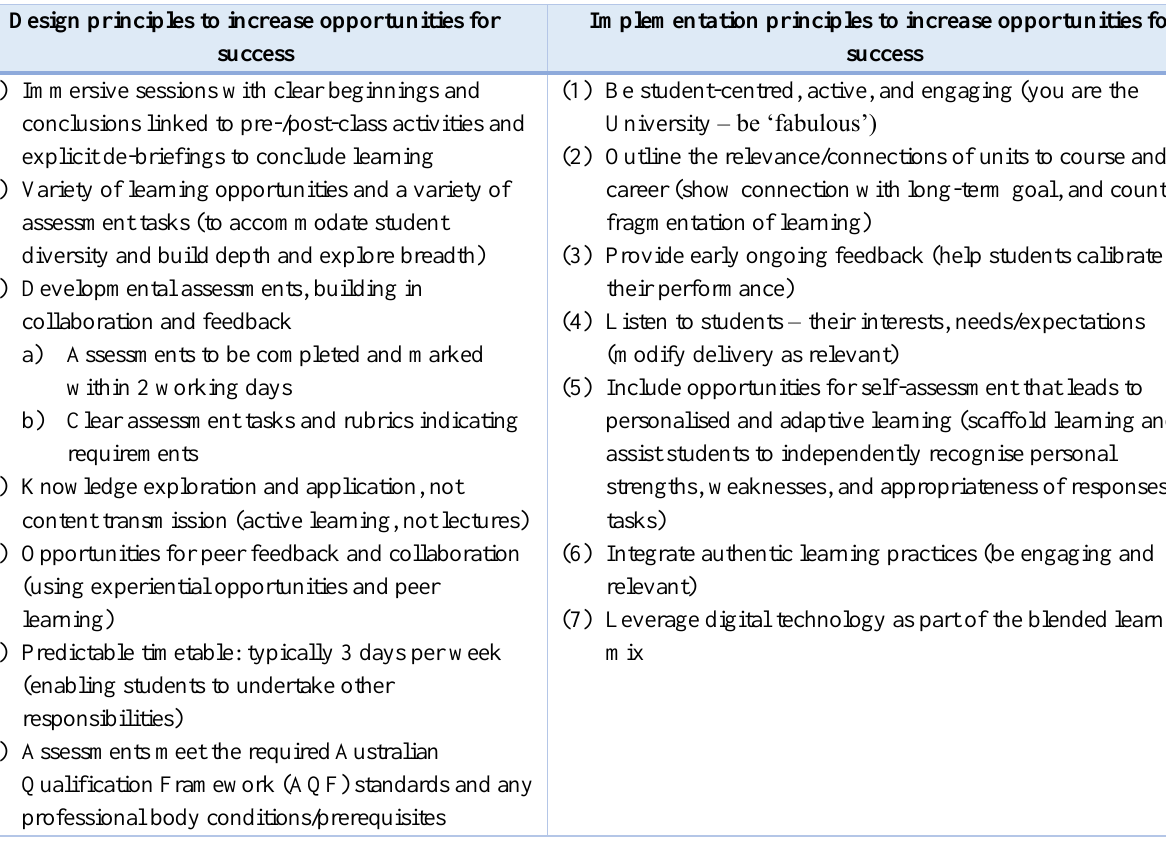
The Block Model Design and Implementation Principles to Increase Opportunities for Success Design principles to increase opportunities for Implementation principles to increase opportunities for success